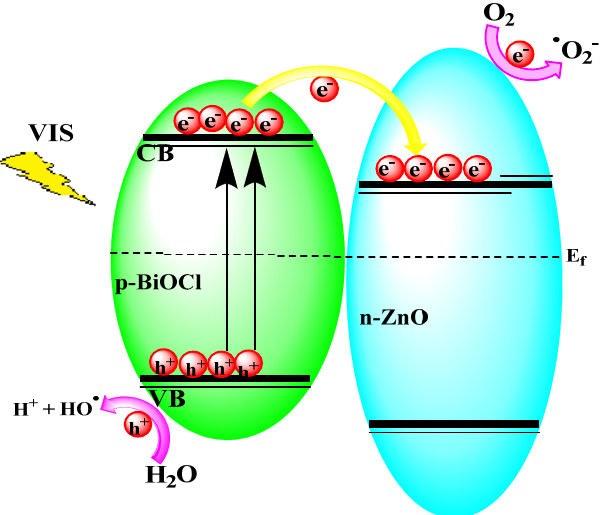
Figure 16. Mechanisms of degradation by BiOCl/ZnO p-n heterojunction materials [61].